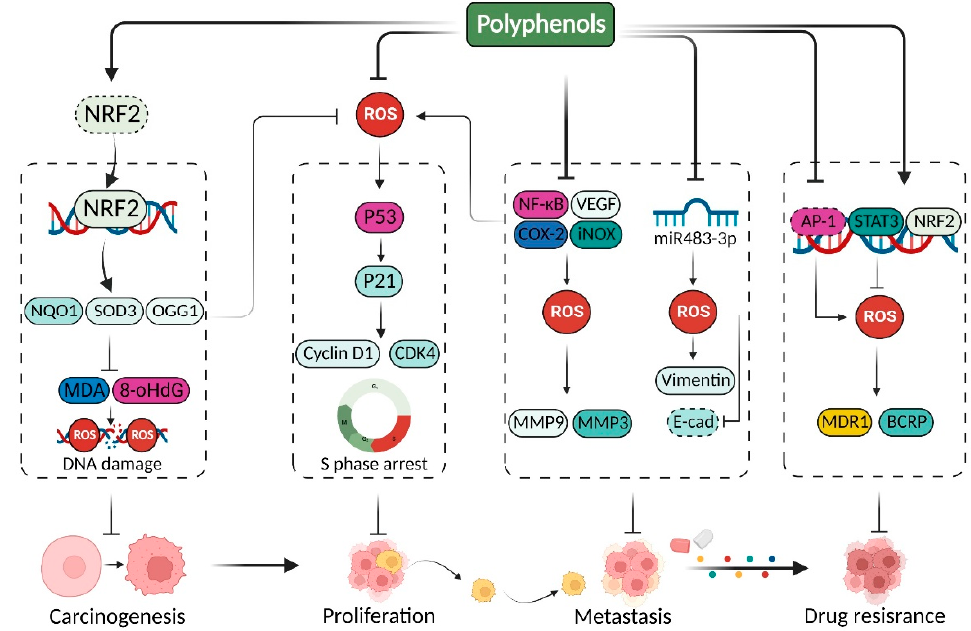
Figure 3. Outlines of antioxidant properties of polyphenols in cancer therapy. Polyphenols can reinforce the transcriptional activation of the classical antioxidant transcription factor NRF2 to defend against ROS-induced DNA damage, thus preventing oxidative stress-mediated carcinogenesis. Meanwhile, polyphenols could also upregulate/activate antioxidant enzymes or activate antioxi- dant signaling pathways to restore intracellular homeostasis for enhancing P21-mediated cell cycle arrest and blocking the epithelial mesenchymal transition (EMT) process and matrix metallopro- teinase (MMP)-mediated metastasis. In addition, polyphenols are able to manipulate the activity of antioxidant or prooxidant transcription factors, thus overcoming ROS-mediated drug resistance. 2.2. Polyphenols Suppressive Cancer by Promoting Oxidative Stress Several kinds of polyphenols also exhibit prooxidant capabilities in cancer therapy. Intriguingly, some kinds of polyphenols exhibit antioxidant activity, but high doses of them induce pro-oxidative stress and lead to DNA damage, lipid peroxidation, inflam- masomes, and autophagosome augmentation [136–139], thus causing apoptosis, ferropto- sis, autophagy, and pyroptosis in cancer cells [140–143]. Obviously, the pro-oxidant mech- anism is similarly involved in the modulation of the redox signaling pathway or the ac- tivity of oxidative enzymes [144,145]. 2.2.1. Curcumin A high dosage of curcumin also exhibits a pro-oxidant potential to suppress tumors. For example, curcumin could evoke cytotoxic cell death in non-small cell lung cancer (NSCLC) by promoting ROS accumulation and mitochondrial transmembrane potential reduction, thus causing DNA damage, G2/M arrest, and subsequent mitochondrial apop- tosis [146]. In addition, several other ROS-mediated cell death models, such as ferroptosis, autophagy, and pyroptosis, could be induced by curcumin to kill cancer cells [147]. For instance, Tang and his coworkers revealed that curcumin administration led to iron over- load, glutathione (GSH) depletion, and lipid peroxidation, causing the downregulation of Recombinant Solute Carrier Family 7, Member 11, and Glutathione peroxidase 4 (GPX4) in lung cancer cells [148]. Moreover, oxidative stress induced autolysosome accumulation and autophagy-dependent ferroptosis, consequently inhibiting the growth and prolifera- tion of cancer cells. In hepatocellular carcinoma, curcumin intervention triggered the ele-